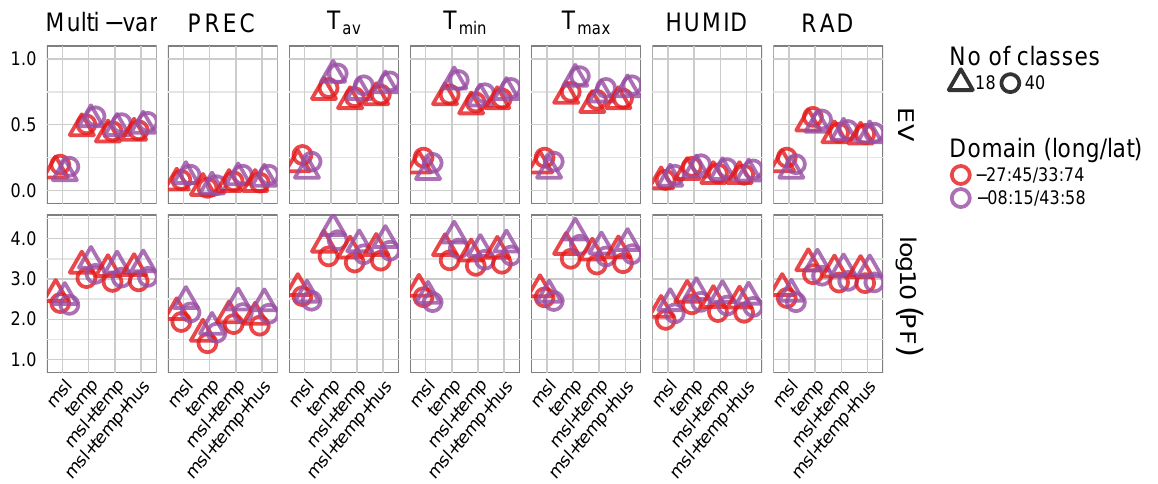
Figure 4. Evaluation metrics for the selection of classification variables ( x axis). Weather variables from station data in columns. Note the log scaling of PF.